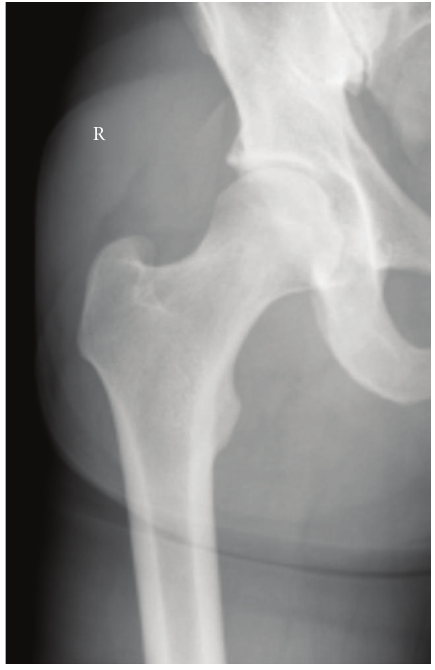
Figure 2: a/p X-ray one week after closed reduction shows a congruent hip joint and no fracture signs.